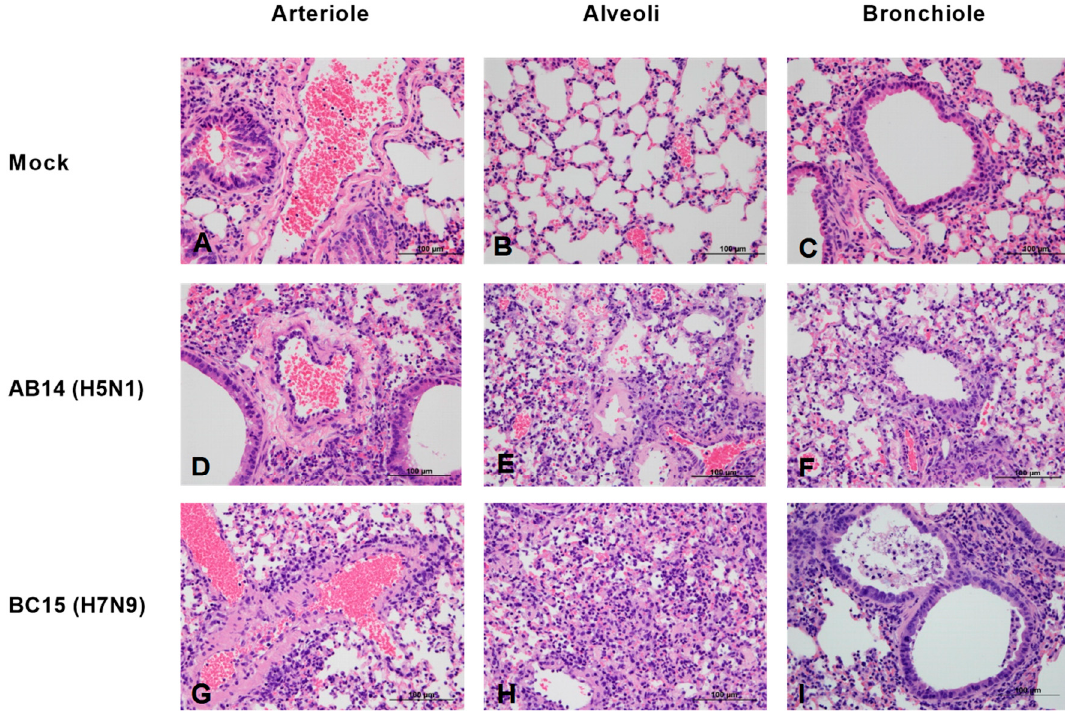
Figure 2. Lung histopathology of mice after infection with AB14 (H5N1) and BC15 (H7N9) strain isolates. Lung samples were fixed, sectioned, and stained with hematoxylin and eosin. ( A – C ) Tissues from mock-infected lungs. ( D – F ) Tissues from mice infected with AB14 (H5N1) showing infiltration of inflammatory cells into the ( D ) wall of the arteriole, ( E ) alveolar walls, and ( F ) bronchiolar epithelium affected by necrosis. ( G – I ) Tissues from mice infected with BC15 (H7N9) showing necrotic debris and inflammatory cells in the ( G ) wall of the arteriole, ( H ) collapsed alveoli, as well as degeneration and necrosis of the ( I ) bronchiolar epithelium. Scale bar represents 100 µm.